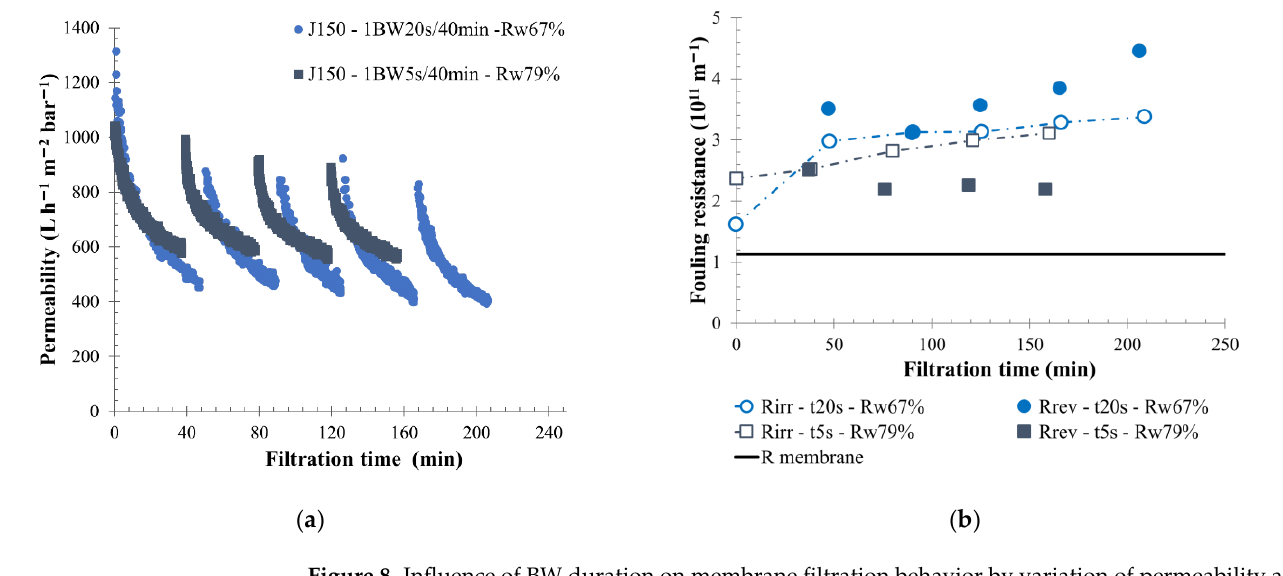
20 ◦ C ( a ) and fouling resistance ( b ) throughout the time with permeate flux of 150 L h − 1 m − 2 , a BW